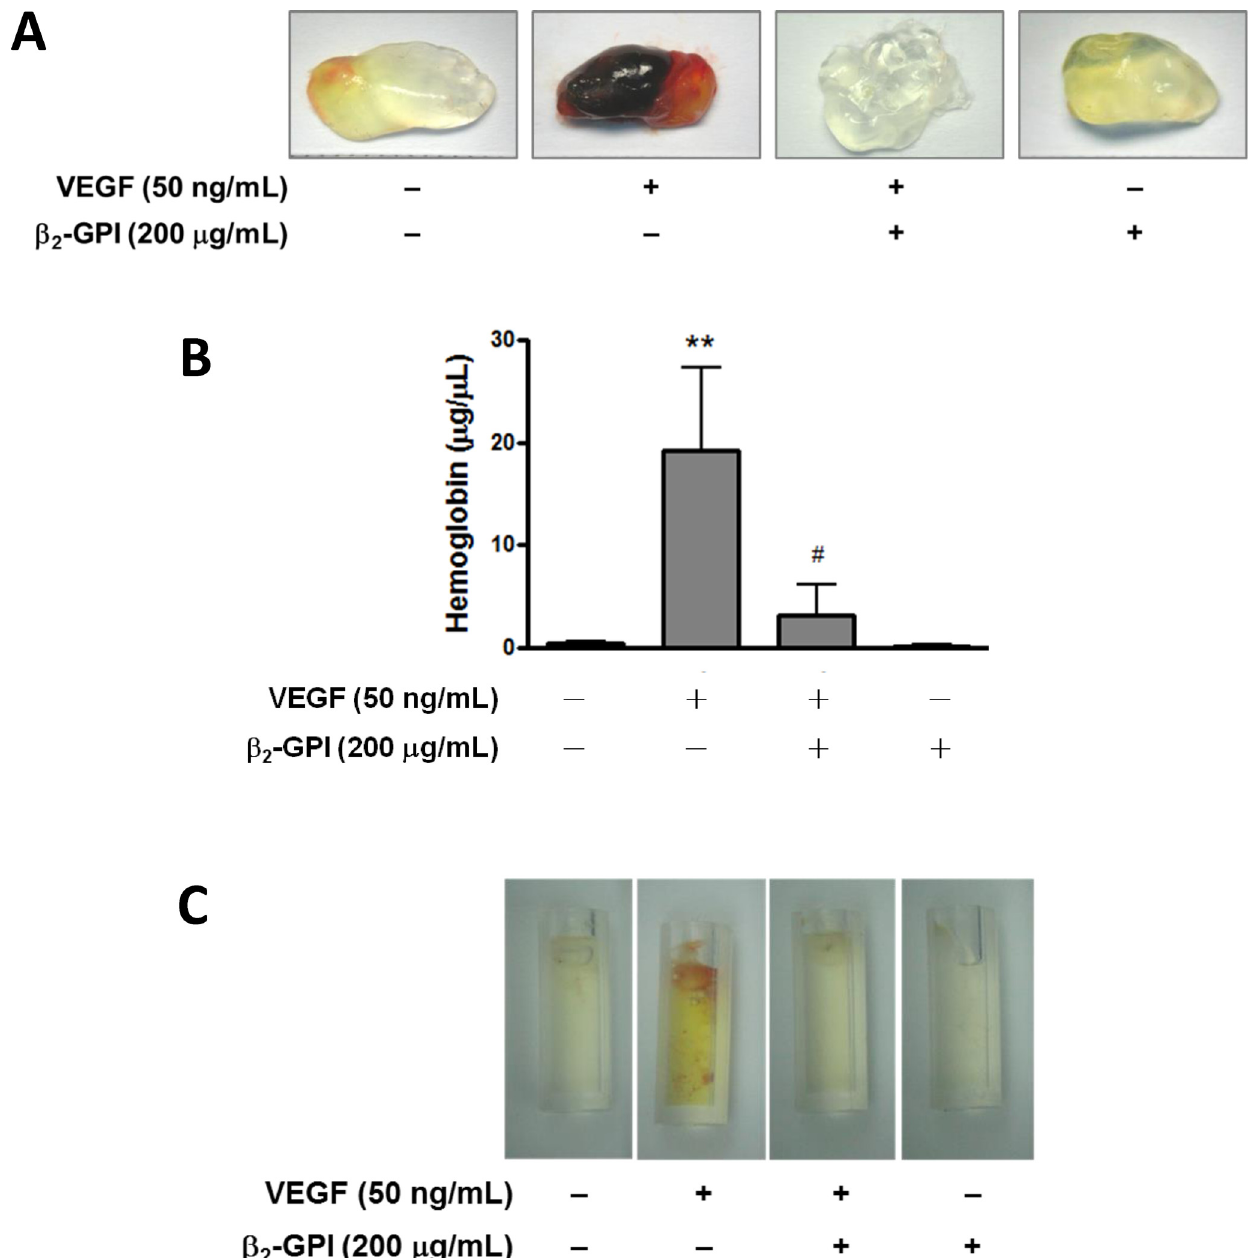
Fig 3. β 2 -GPI inhibits the VEGF-induced angiogenesis in mice. (A) C57BL/6 mice were injected subcutaneously with 0.5 ml Matrigel containing with or without VEGF in combination with β 2 -GPI at indicated concentrations (n = 6 – 8 per group). After 14 days, Matrigel plugs were removed and representative images were taken as shown. (B) Quantitative evaluation of angiogenesis in Matrigel plugs was determined by hemoglobin using the Drabkin ’ s reagent kit. Bar graphs represent the quantitative analysis of the hemoglobin content of plugs expressed as mean ± SEM. ** p < 0.01 versus control; # p < 0.05 versus VEGF treatment alone. (C) The effect of β 2 -GPI on the VEGF-induced angiogenesis was also detected using an angioreactor-based in vivo assay. Angioreactors with or without VEGF in combination with β 2-GPI were implanted subcutaneously into the dorsal flank of C57BL/6 mice for 14 days, and vessels allowed to infiltrate. Two silicone tubes were implanted per mouse. Angioreactors are photographed using a Canon powershot G9 digital camera and the representative images were taken as shown.